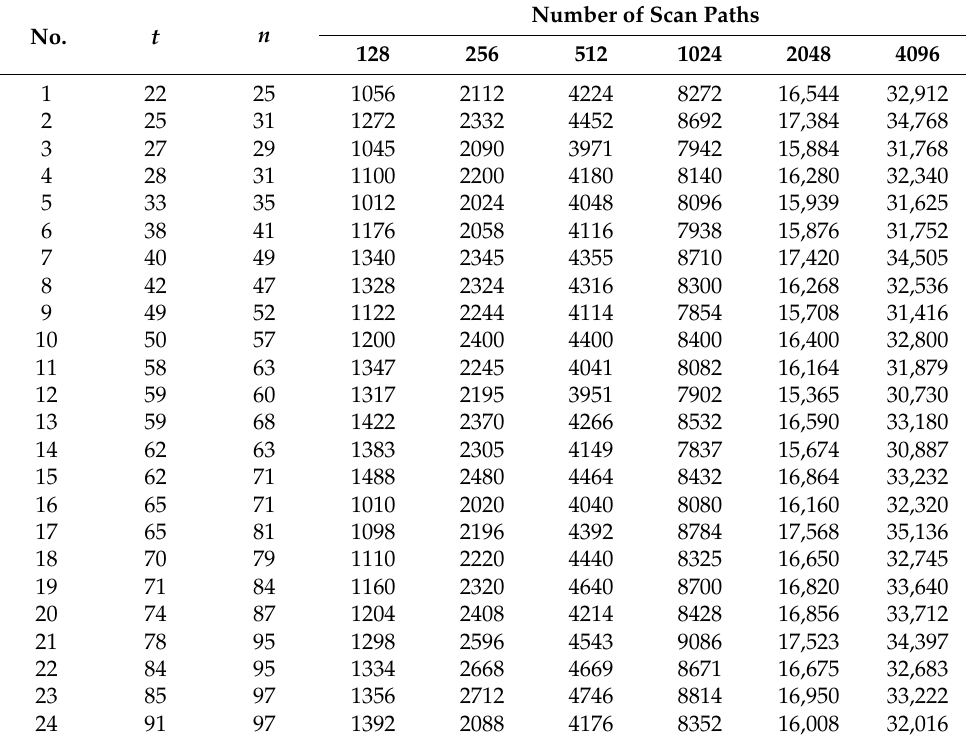
Table 7. Implementation costs for test pattern generators of the DT-LFSR-TPG